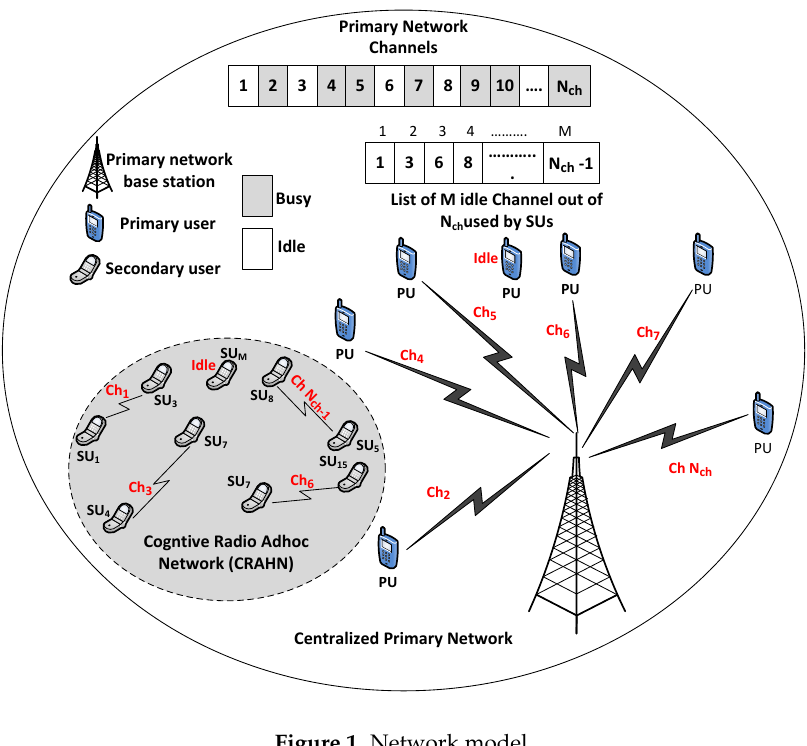
Figure 1. Network